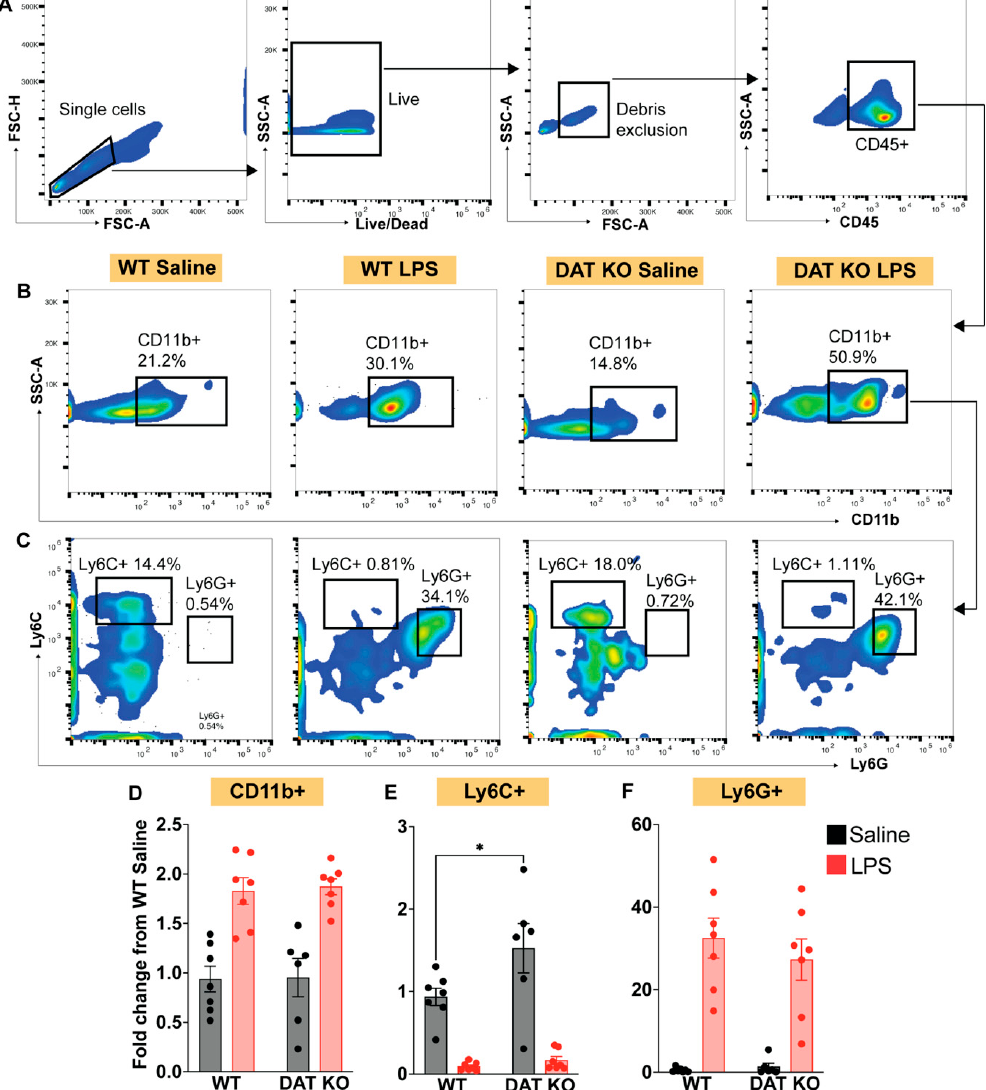
Figure 3. DAT − / − results in exaggerated baseline inflammatory phenotype in peripheral circulating myeloid cells. Adult homozygous DAT − / − animals were treated with saline or tail-vein LPS to mimic acute endotoxemia alongside wildtype littermate controls. ( A ) After gating of single, live cells, free from debris, CD45+ leukocytes were assessed for expression of ( B ) CD11b, which were further assessed for ( C ) Ly6C and Ly6G expression. ( B ) Peripheral blood immunophenotyping reveals that, while DAT − / − and WT animals exhibit similar baseline and LPS-stimulated CD11b+ cells ( D ) and Ly6G+ reactive neutrophils ( F ), we observed an exaggerated baseline inflammatory monocyte phenotype in DAT − / − animals ( E ), suggesting that systemic DAT − / − sets the stage for altered/exaggerated response to endotoxin exposure. (Two-way ANOVA with Sidak’s post hoc test for multiple comparisons; n = 6–9 per group. * p < 0.05).